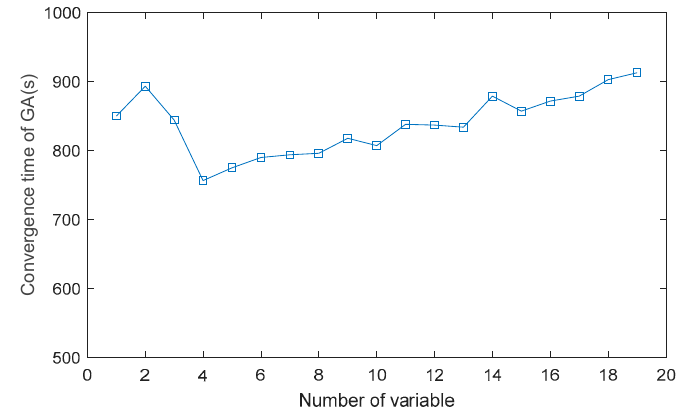
Figure 9. The convergence time of GA for finding the solutions with different variable number.